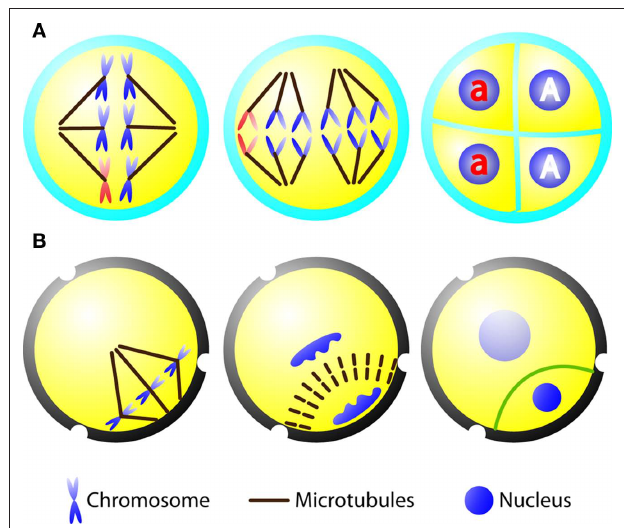
Figure 1 | Diagrams depicting microsporocyte meiosis and pollen mitosis i in A . thaliana . (A) Sequential diagrams showing the spindle of meiosis I (left), two spindles of meiosis II (middle), and tetrad (right) containing two wild type microspores (highlighted as “A”) and two mutant ones (highlighted as “a”). The chromosomes carrying the mutation are shown in red. (B) Diagrams demonstrating pollen mitosis I with asymmetrically positioned spindle (left) and phragmoplast (middle). A curved cell plate (green line) is formed to result in a lens-shaped generative cell with densely packed chromatin and a larger vegetative cell with loosely packed chromatin